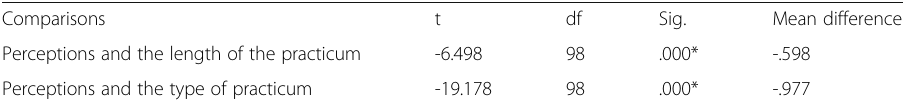
Table 6 The results of t-tests Comparisons